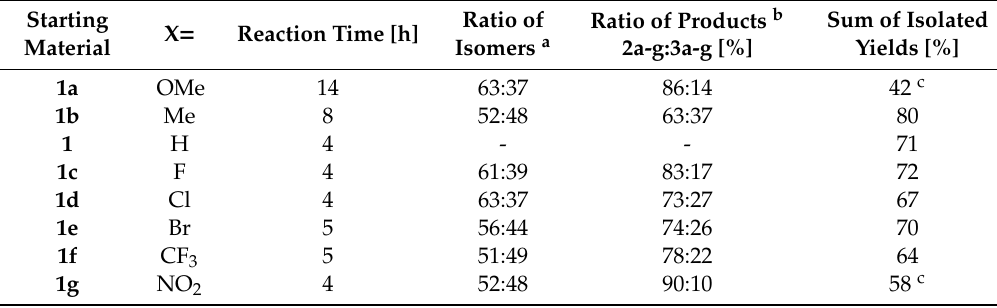
Table 1. Photocyclization of imines 1a - g —regioselectivities and yields.